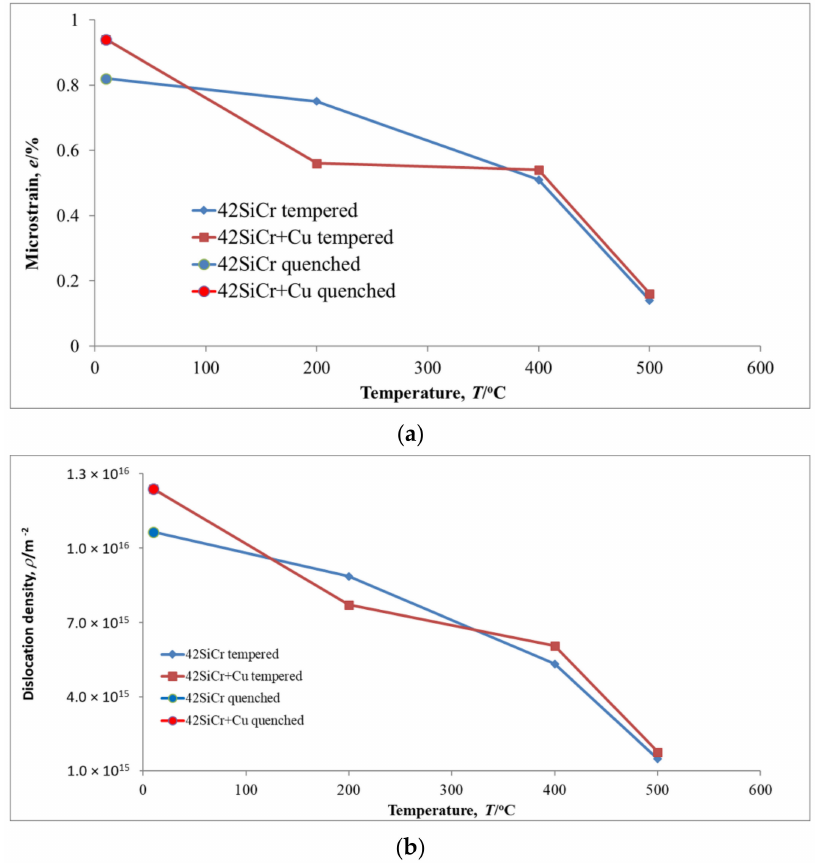
Figure 3. Variation in microstrain e ( a ) and dislocation density ρ ( b ) of 42SiCr and 42SiCr + Cu steels after quenching and then tempering for 2